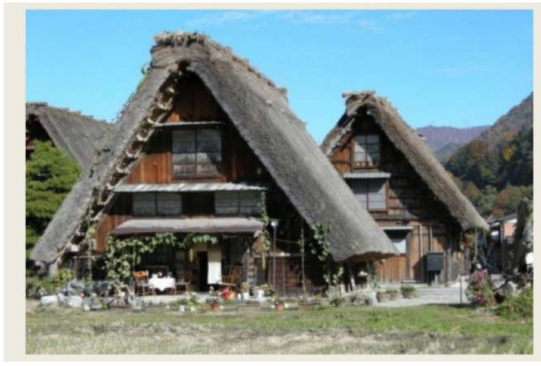
Figure 5. A Minka building, a traditional house in Japan, with roofs covered by straw and wooden structures. Photograph: Veronica